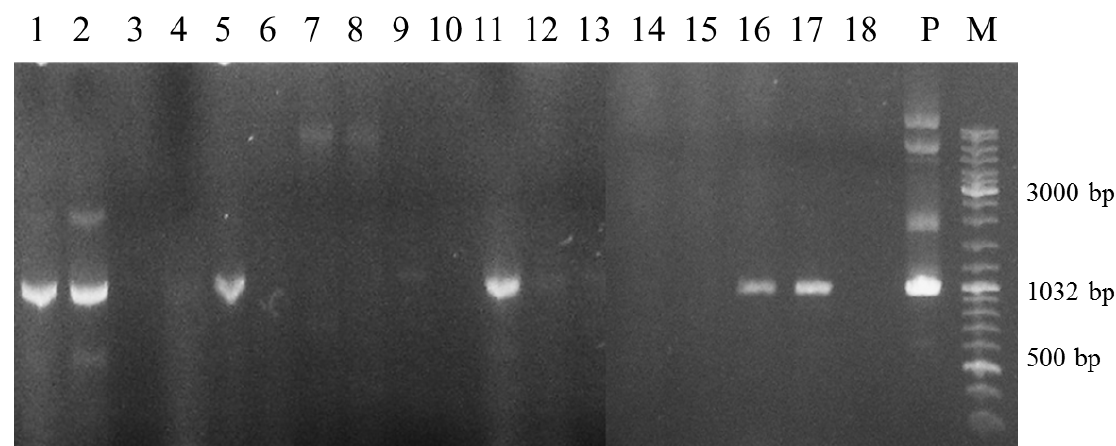
FIGURE 2 - Colony PCR of Pichia transformants with pPICZαA–INF-β-1a. Lane 1-18: eighteen Zeocin-resistant transformants; M: DNA marker; P: The positive control used the expression vector pPICZαA–INF-β-1a.